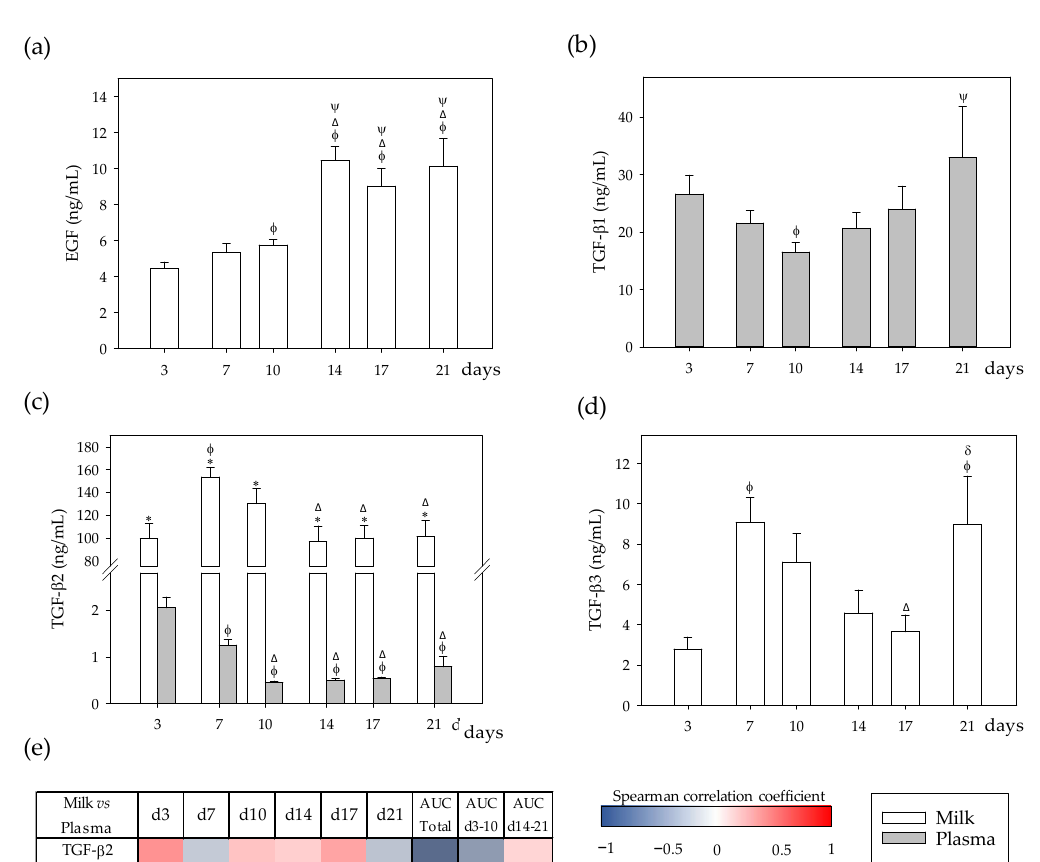
Figure 3. ( a ) Milk and plasma concentration of growth factors in dams: epidermal growth factor (EGF), ( b ) transforming growth factor (TGF)- β 1, ( c ) TGF- β 2, and ( d ) TGF- β 3 throughout the lactation period. ( e ) Correlations between milk and plasma TGF- β 2 levels at specific days (3, 7, 10, 14, 17, and 21), while also considering their area under the curve during the whole lactation period (AUC total ), and AUC on the first (AUC d3–10 ) and the second period (AUC d14–21 ) of the study. The Spearman correlation coefficient is represented in the heat map following the color in the legend. Correlations with statistical significance ( p < 0.05) are shown in a bold frame. EGF and TGF- β 3 were not detected in plasma, and TGF- β 1 was not detected in milk. Statistical differences: * p < 0.05 vs. plasma on the same day; φ p < 0.05 vs. day 3, ∆ p < 0.05 vs. day 7, ψ p < 0.05 vs. day 10, and δ p < 0.05 vs. day 17 for the same type of sample ( N = 6–8).